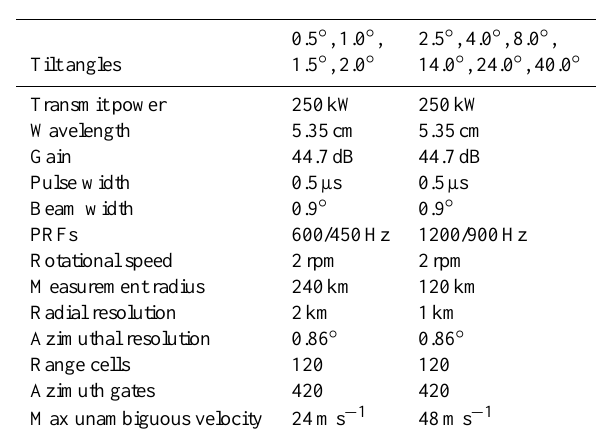
Table 1. Selected characteristics of Swedish weather radars.